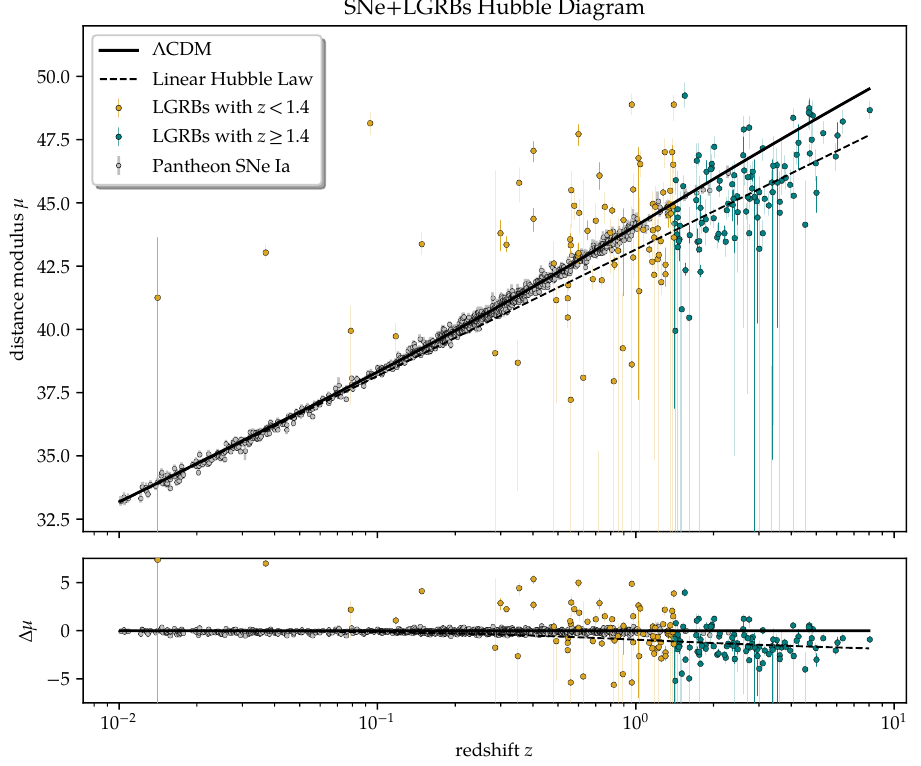
Figure 6. The Hubble diagram for our sample of 174 LGRBs together with the type Ia SNe form the Pantheon